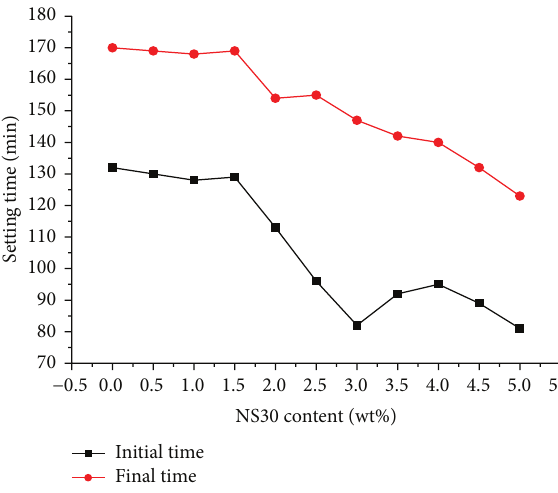
Figure 8: Variation in setting time (initial and final) on the mortar with the NS30